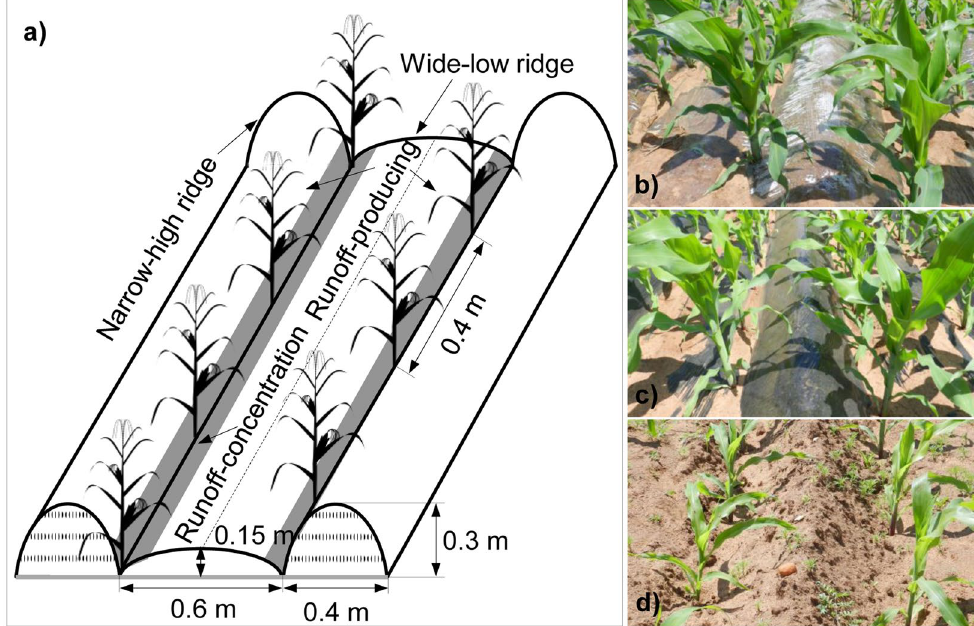
Figure 5. The schematic diagram of alternative ridge-furrow unit ( a ) and different mulching materials ( b , c and d ) in both experimental